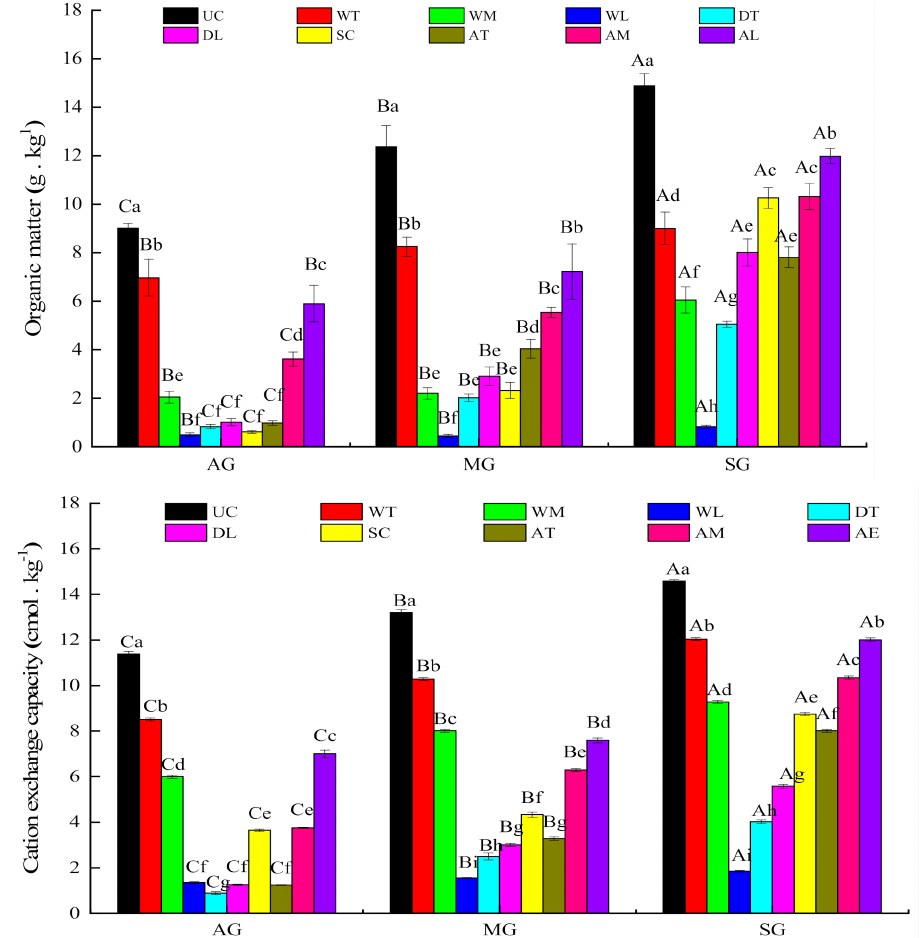
Figure 8. The soil organic matter and cation exchange capacity in the different spatial positions in different stages of Benggang